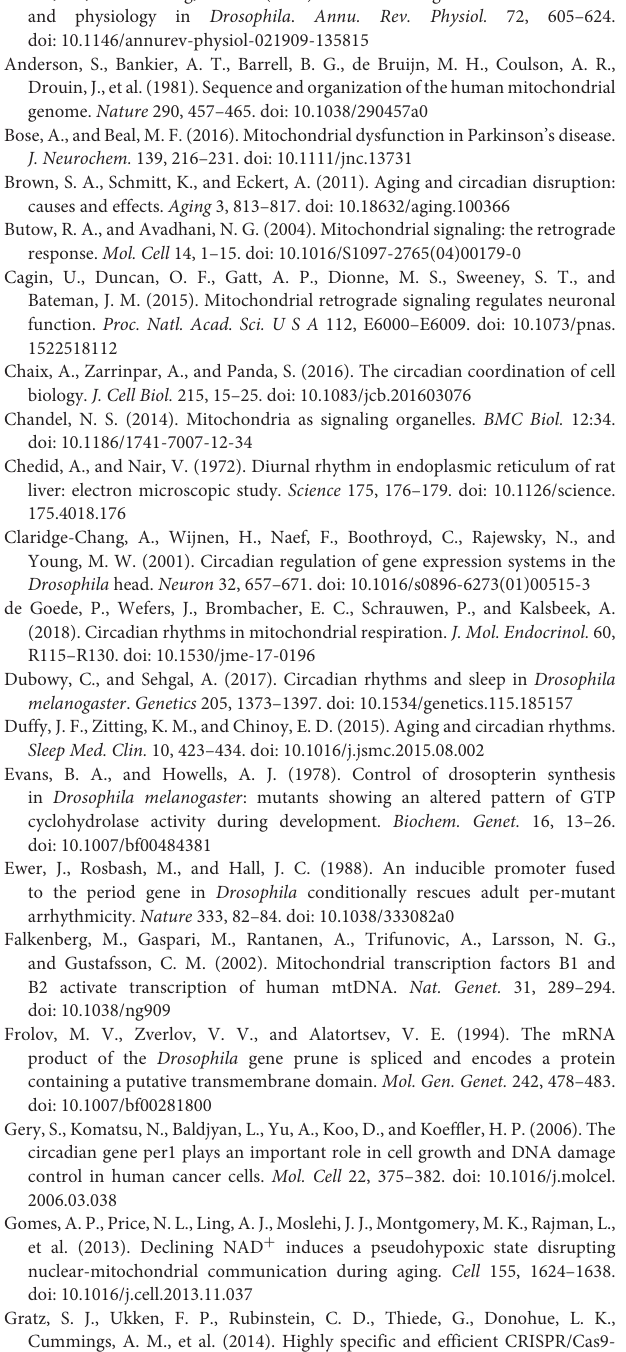
FIGURE S3 | Oscillation of PERIOD in the circadian neurons of control and pn (cid:52) mutant flies. Adult brains were dissected at CT 1, 5, 9, 13, 17, 21 at DD1 and circadian neurons were immunostained with anti-PERIOD. Quantification of average intensity in each clock cell group ( n = 10) was shown as means ± SEM. Signal was normalized to the value at CT1 which was set as 100%. CT is indicated on the x axes. Two independent repeats were performed. ∗ P < 0.05, ∗∗ P < 0.01, ∗∗∗ P <